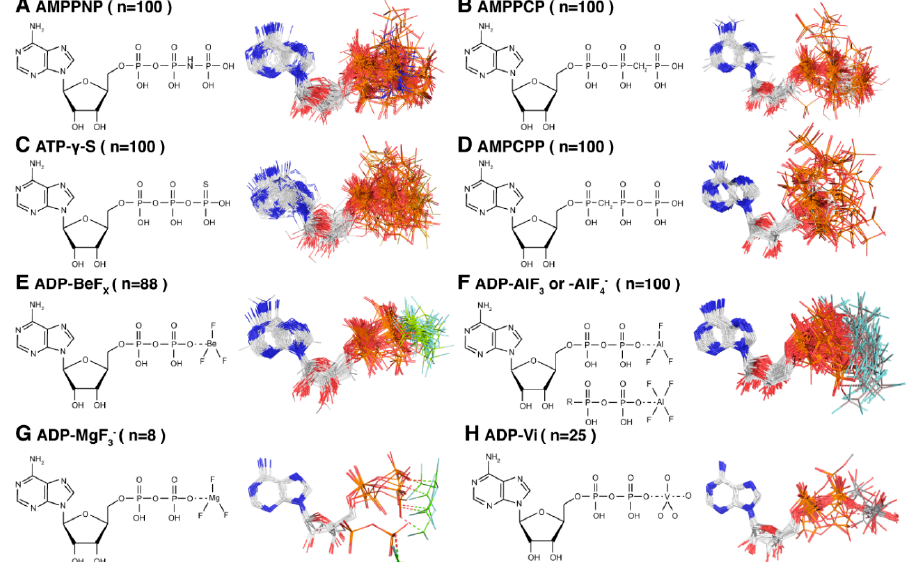
Figure 3. ATP analogues mainly used for structure determination. Left panel is the chemical structure and the right panel shows the protein-bound-structure of AMPPNP ( A ), AMPPCP ( B ), ATP- γ -S ( C ), AMPCPP ( D ), ADP:BeF x ( E ), ADP:AlF x ( F ), ADP:MgF 3 − ( G ), ADP:Vi ( H ) from the Protein Data Bank (https://www.rcsb.org). The protein-bound-structures of ATP analogues were generated after alignment of their adenosine moieties. In order to compare the molecules among each other, only the first 100 structures with the smallest RMSD were selected for AMPPNP, AMPPCP, ATP- γ -S and